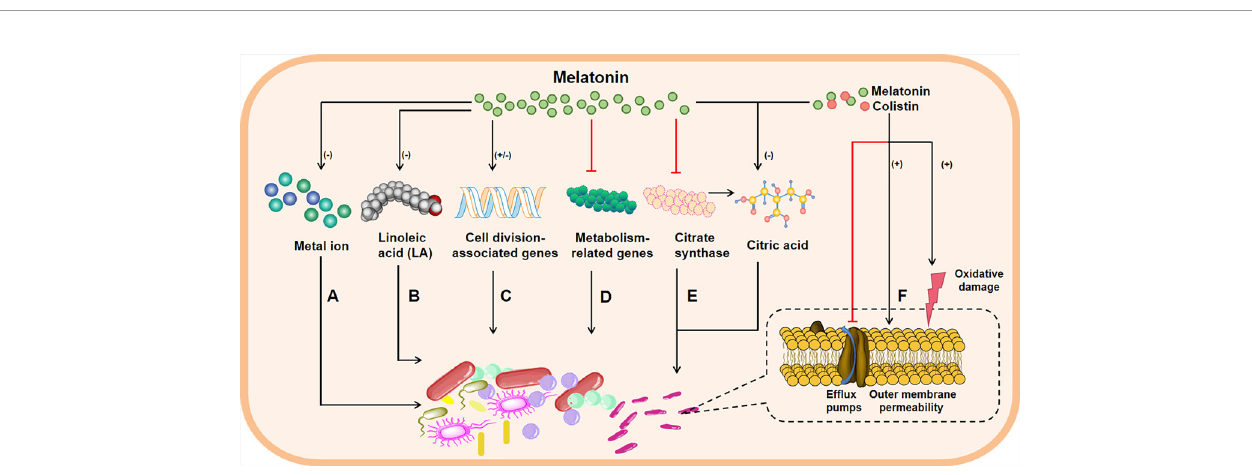
FIGURE 1 | The possible bacteriostatic mechanisms of melatonin in vitro. Melatonin inhibits the growth of bacteria through these avenues: reducing cytoplasmic availability of metal ion (A) ; interfering cell wall formation, for example, melatonin restricts the absorb of Linoleic acid (LA), which makes up the cell wall, thus limiting cell proliferation (B) ; melatonin can also regulate the expressions of genes associated with cell division (C) or suppress the content and activity of metabolism-related enzymes (D) to inhibit bacterial growth and proliferation; melatonin resists against Gram-negative bacteria through inhibiting bacterial citrate synthase and reducing the synthesis of citric acid (E) , besides, when melatonin is combination with colistin, bacterial outer membrane permeability and oxidative damage are enhanced, and the effect of ef fl ux pumps is inhibited (F) , leading to increased bacteria damage. Note: minus in parentheses represents decrease; plus in parentheses represents increase; and the red line represents inhibition; the black arrow indicates activation.